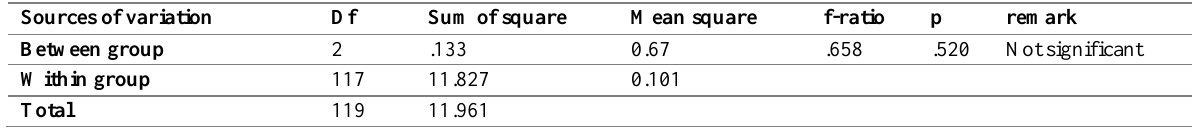
Table 6: The ANOVA Analysis of Responses of the Three Groups of Electrical/Electronic Service Personnel Base on their Years of Experience on the Rate of Musculoskeletal Disorder Related Accidents at the Electrical/Electronics Workshop. Sources of variation Df Sum of square Mean square f-ratio p remark Between group 2 .133 0.67 .658 .520 Not significant Within group 117 11.827 0.101 Total 119 11.961